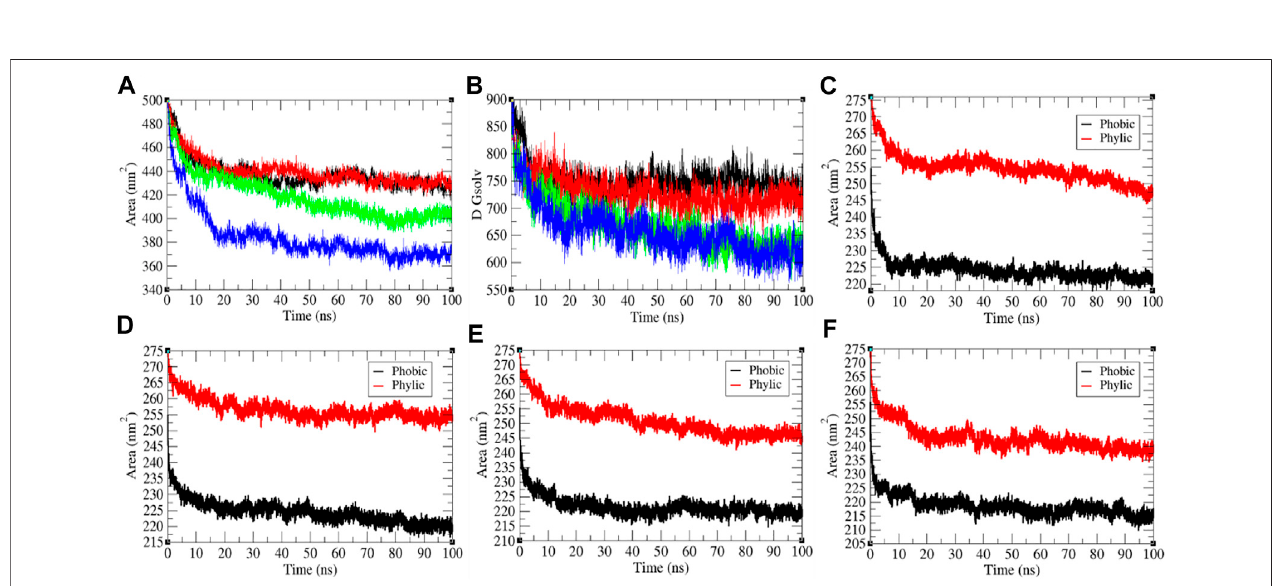
FIGURE 3 | The solvent accessible surface area of the SARS-CoV-2 S protein. (A) SASA vs. time. (B) Free energy of solvation vs. time. The color codes have the same meaning as described in Figure 2 . It was resolved into hydrophobic and hydrophilic regions for the SARS-CoV-2 S protein at (C) 0 ° C, (D) 20 ° C, (E) 40 ° C, and (F) 60 ° C,